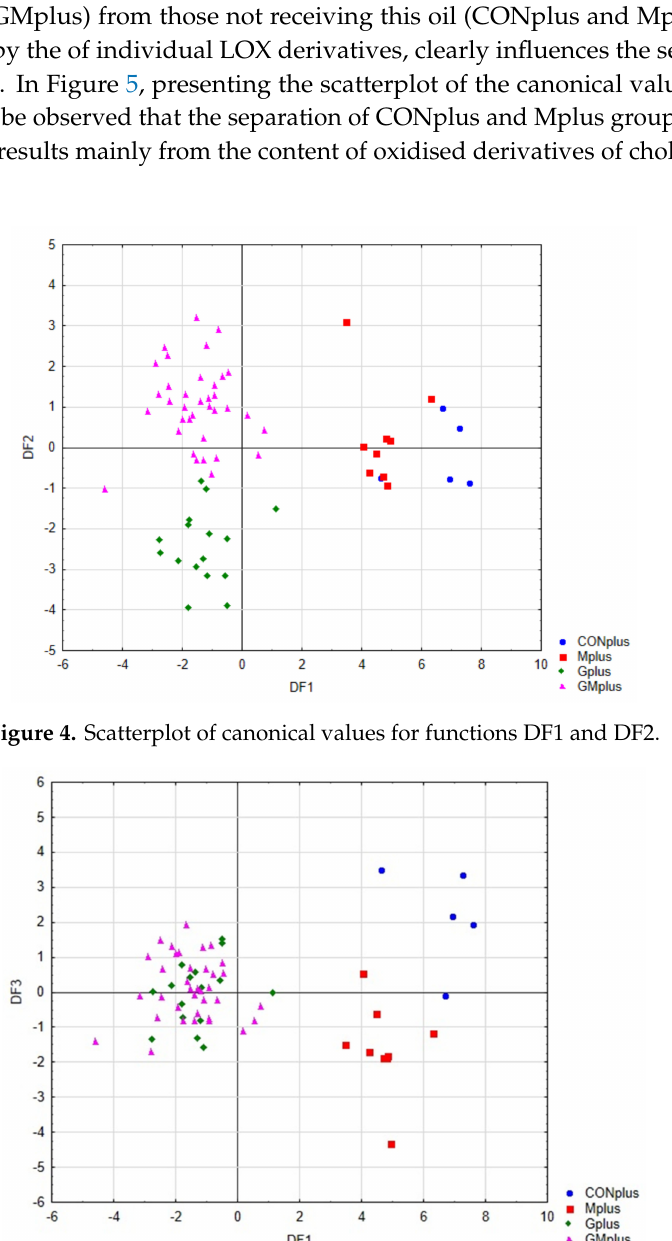
Figure 5. Scatterplot of canonical values for functions DF1 and